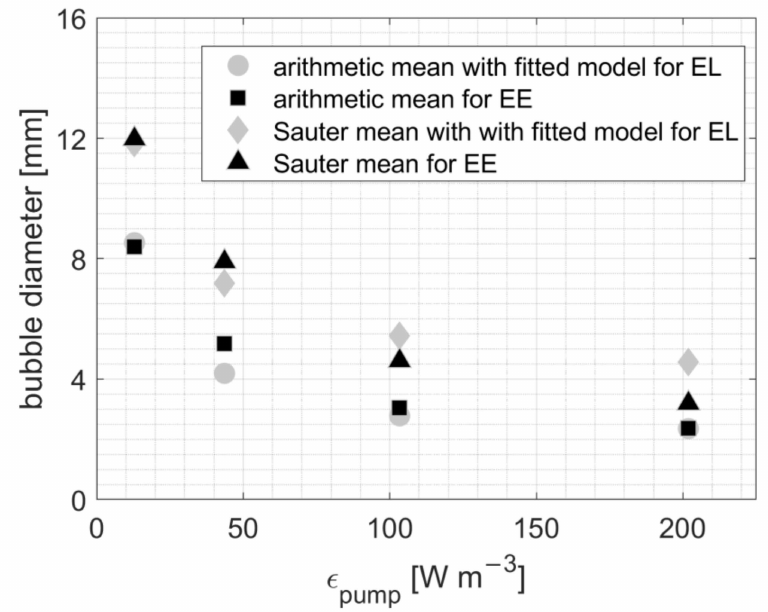
Figure 9. Arithmetic diameter and Sauter diameter of the bubble breakage model given by Luo et al. The solution is compared with the EE approach and the fitted model in EL. Shown for pump volume flow 13, 44, 103 and 202 W m − 3 .